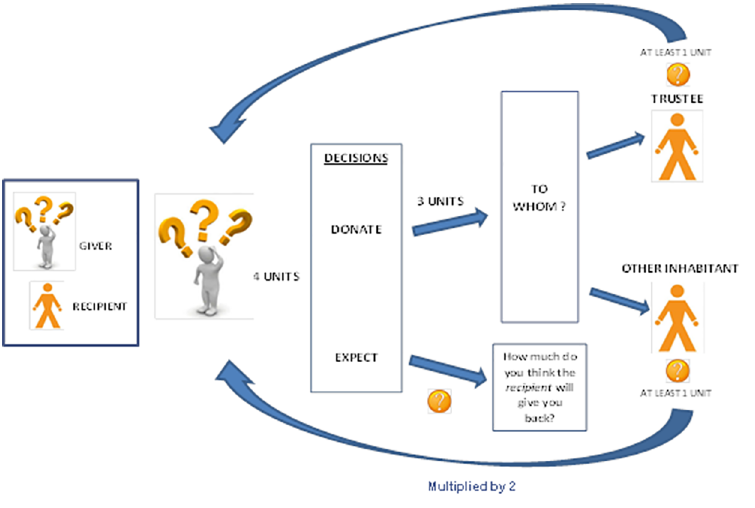
Fig 3. Representation of the